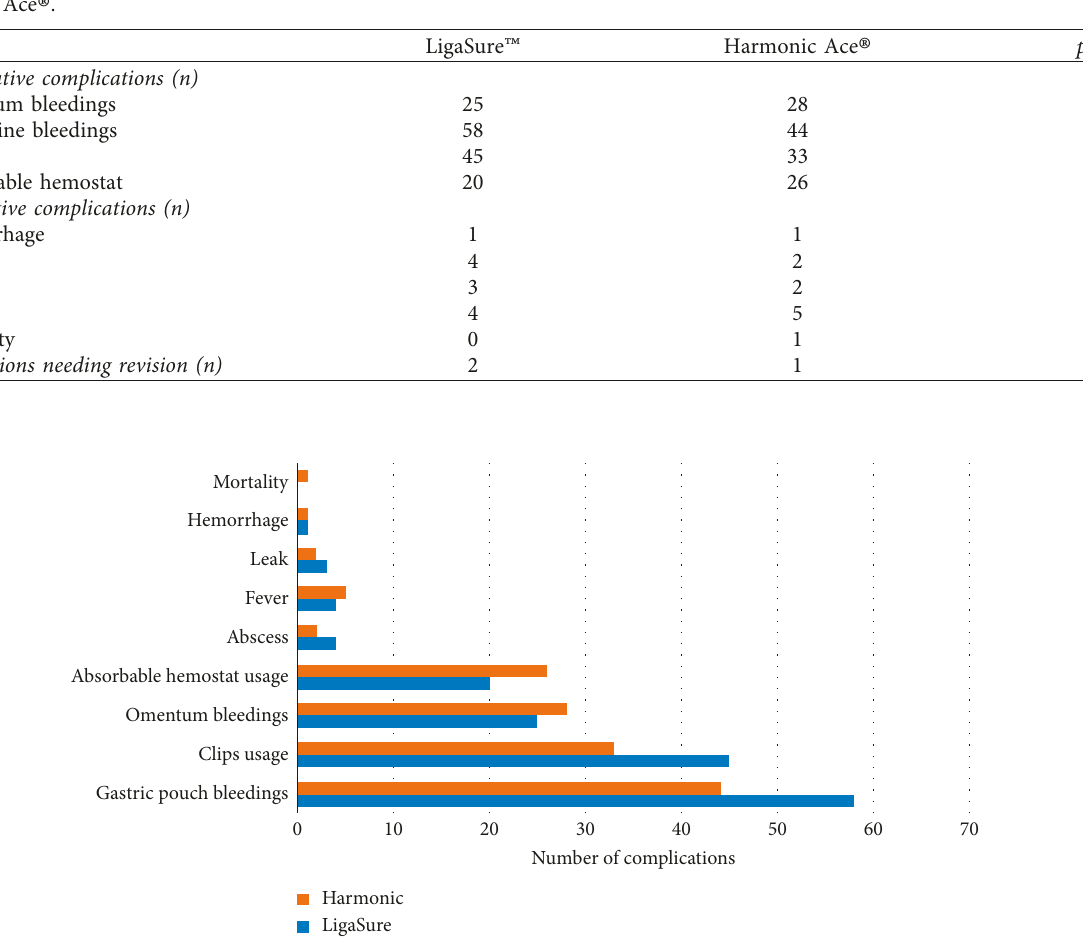
Figure 1: Intraoperative and postoperative complications occurred with Harmonic ® and LigaSure ™ in the patients’ cohort (within 30